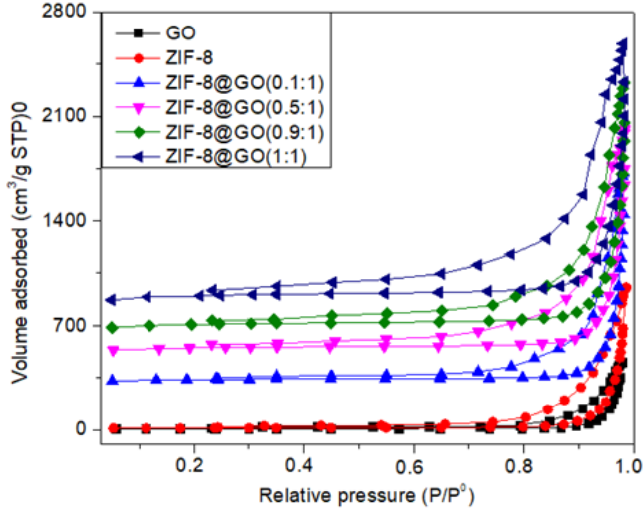
Figure 6. N 2 sorption isotherms of GO, ZIF-8 and ZIF-8@GO composites.